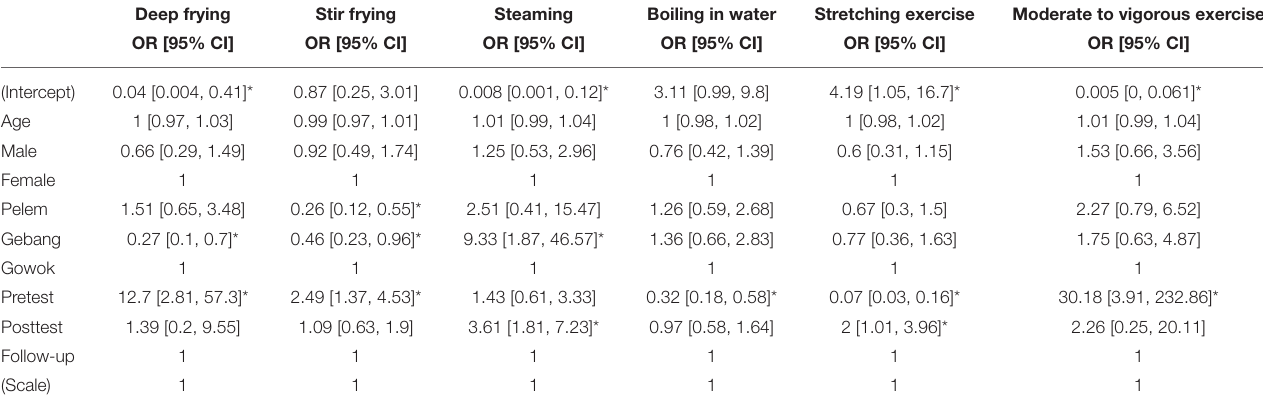
TABLE 4 | Odds ratios and 95% confidence intervals of cooking methods and stretching and physical exercises longer than recommendations. Deep frying Stir frying Steaming Boiling in water Stretching exercise Moderate to vigorous